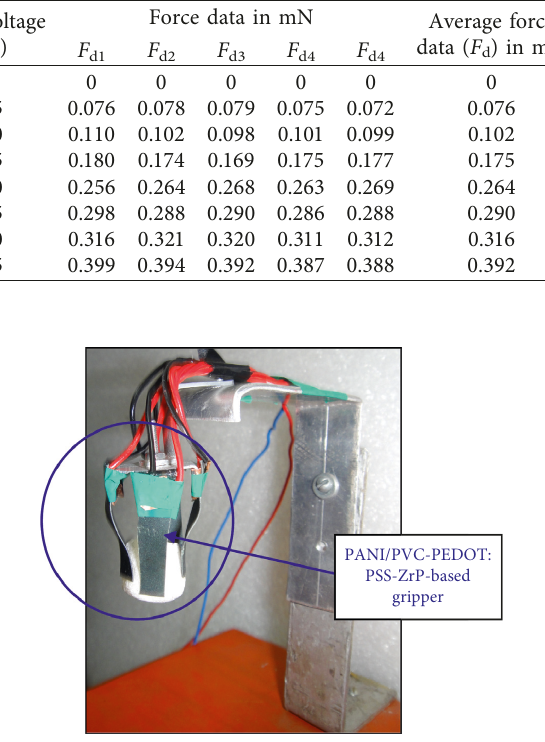
Figure 14: A prototype of PANI/PVC-PEDOT: PSS-ZrP-based microgripping system.